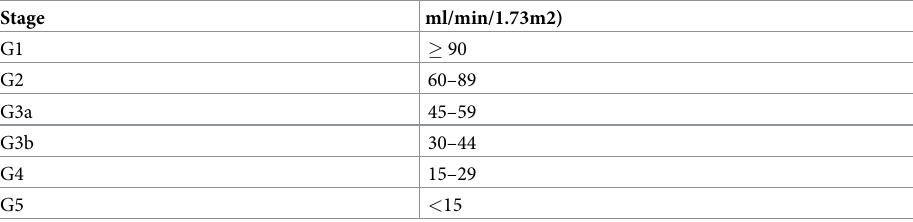
Table 1. Classification of CKD by categories according to glomerular filtration